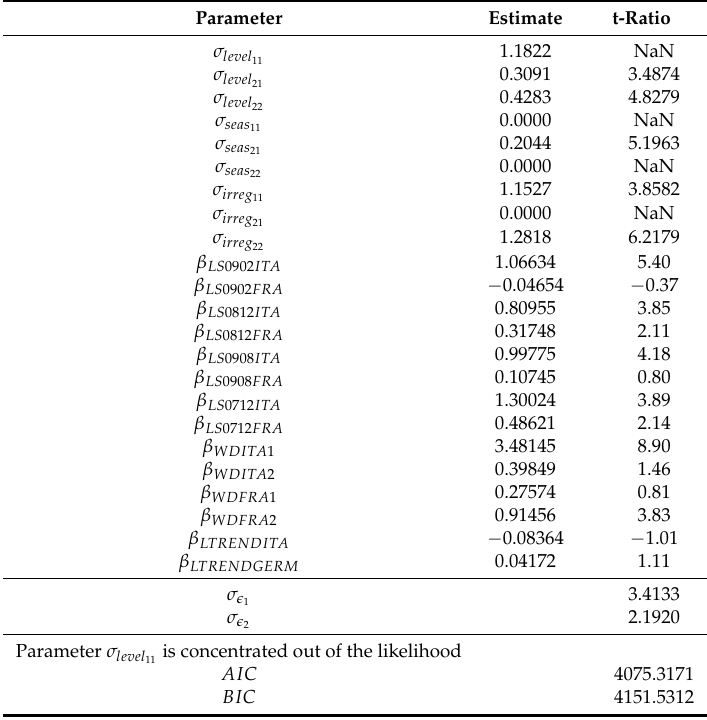
Table A6. Barebone model variables: IPI t intermediate goods LCVFR t in France.